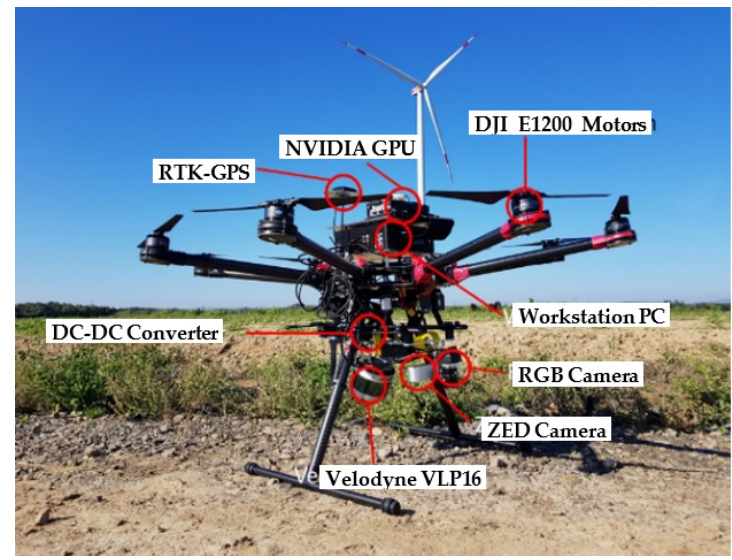
Figure 15. Unmanned aerial vehicle for WT inspection.